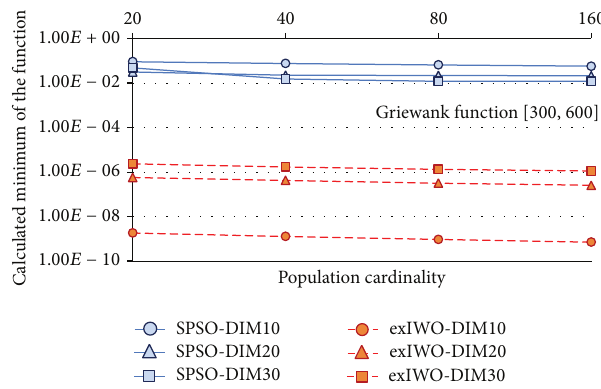
Figure 16: Comparison between SPSO and exIWO based on the Griewank function.